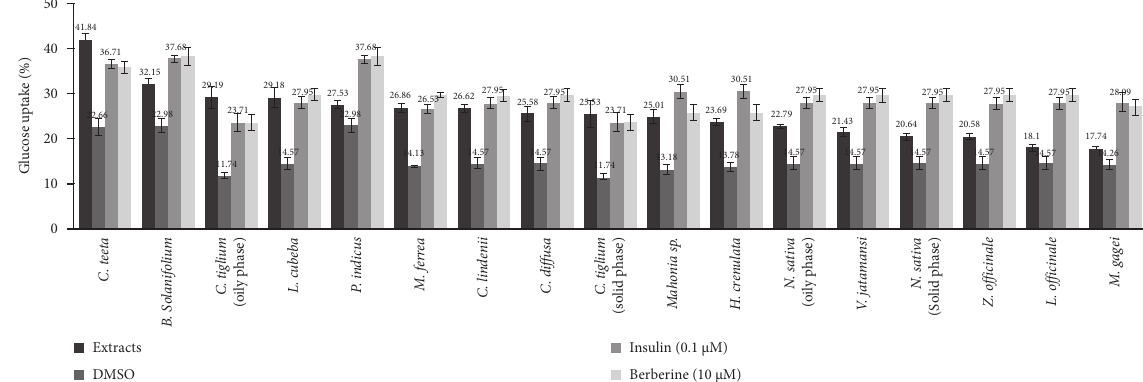
Figure 1: The effects 17 extracts (40 μ g/mL) of 15 plant species on glucose uptake of 3T3-L1 adipocytes. Data is represented as percentage of glucose uptake, in comparison to the control group (DMSO) and positive control (insulin and